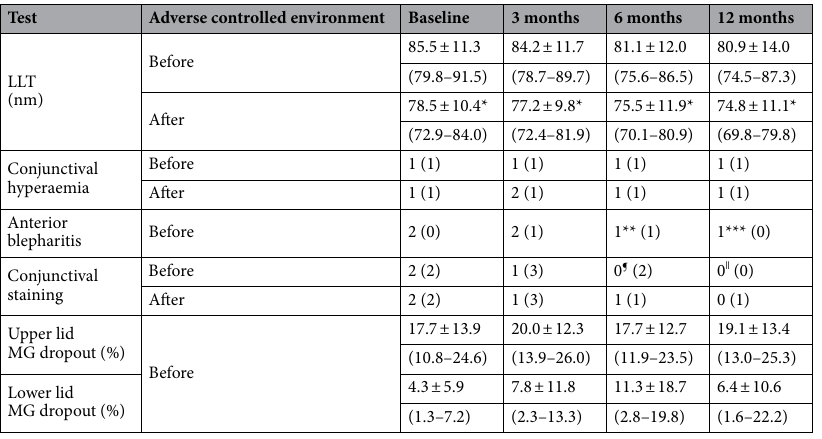
Table 3. Outcomes of LLT, conjunctival hyperaemia, anterior blepharitis grade, conjunctival staining, and MG drop out. LLT = lipid layer thickness, MG = Meibomian gland. Values of LLT and MG drop out are means ± standard deviation and (95% confidence interval). Values of conjunctival hyperaemia, anterior blepharitis, and conjunctival staining are median and (interquartile range). *Comparison with before adverse controlled environment p < 0.0001 (lineal mixed model). **Comparison with baseline value by post-hoc Tukey´s test, p = 0.0005 (cumulative logit mixed model). ***Comparison with baseline value by post-hoc Tukey´s test, p < 0.0001 (cumulative logit mixed model). ¶ Comparison with baseline value by post-hoc Tukey´s test, p = 0.01 (cumulative logit mixed model). ‖ Comparison with baseline value by post-hoc Tukey´s test, p = 0.0007 (cumulative logit mixed model).